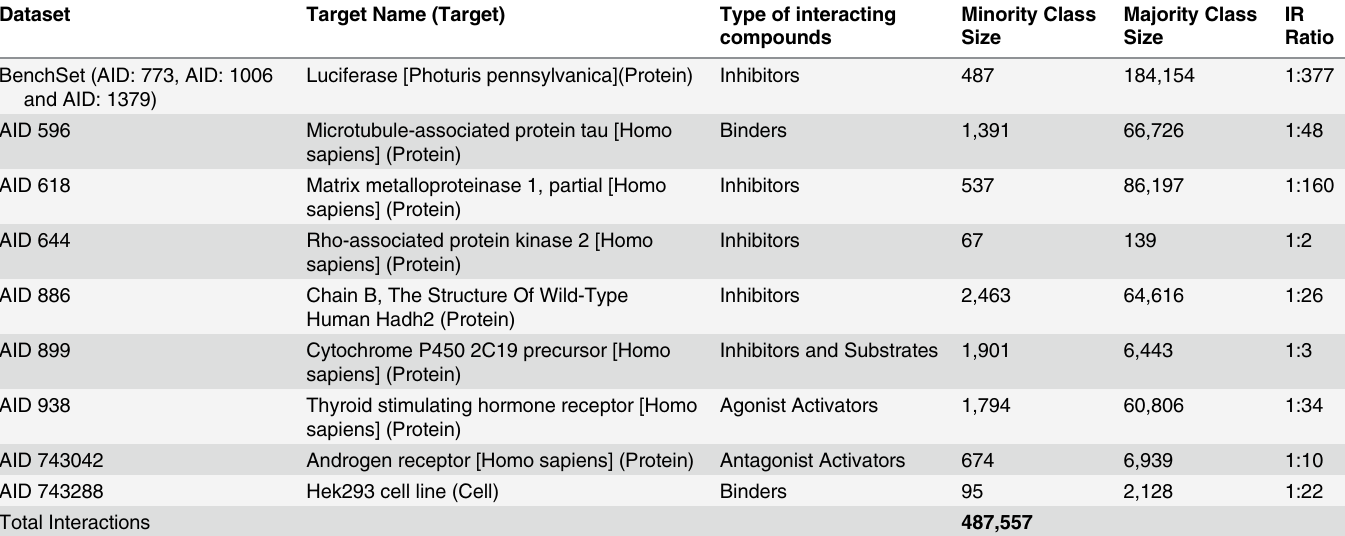
Table 1. Summary of experimental datasets including reference IDs in PubChem Database.